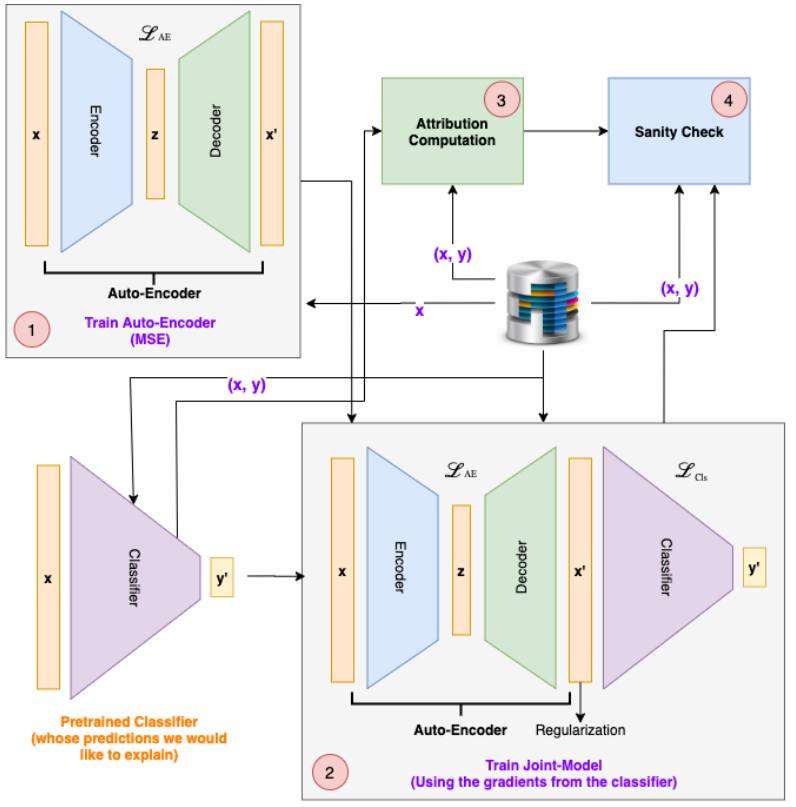
Figure 1. System